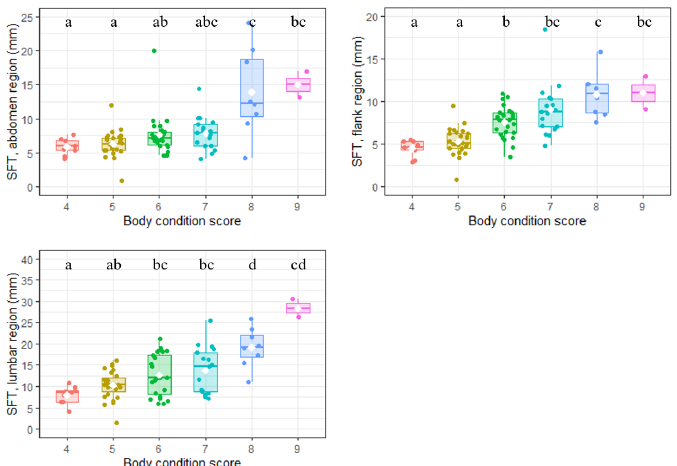
Figure 3. Relationship between body condition score and subcutaneous fat thickness ( n = 88 Labradors). Note: SFT was measured at three anatomical sites ( fl ank, abdomen and lumbar region). Within each box the di ff erent horizontal lines, from bo tt om to top, represent the 25th percentile, median and 75th percentile values. The white diamonds denote the mean value in the considered group. For each plot, groups sharing a le tt er were not signi fi cantly di ff erent ( p > 0.05). Pairwise comparisons were conducted using a Dunn test with Benjamini–Hochberg correction following a Kruskal–Wallis rank sum test showing a signi fi cant relationship between BCS and SFT at the anatomical site considered. The scales of the y-axes are di ff erent between the three graphs.